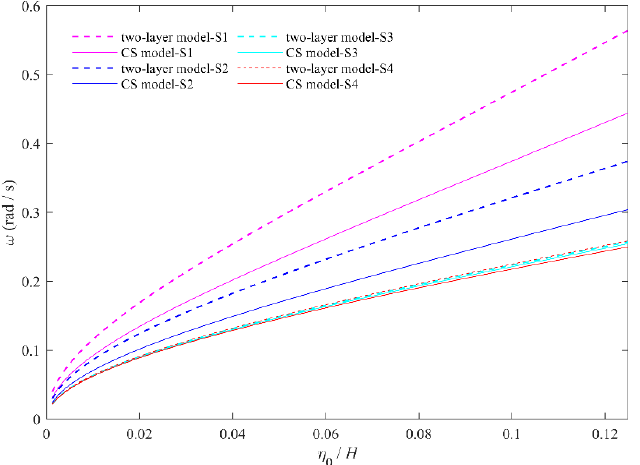
Figure 6. The theoretical frequency–amplitude relationship in S1–S4, where CS refers to continuously